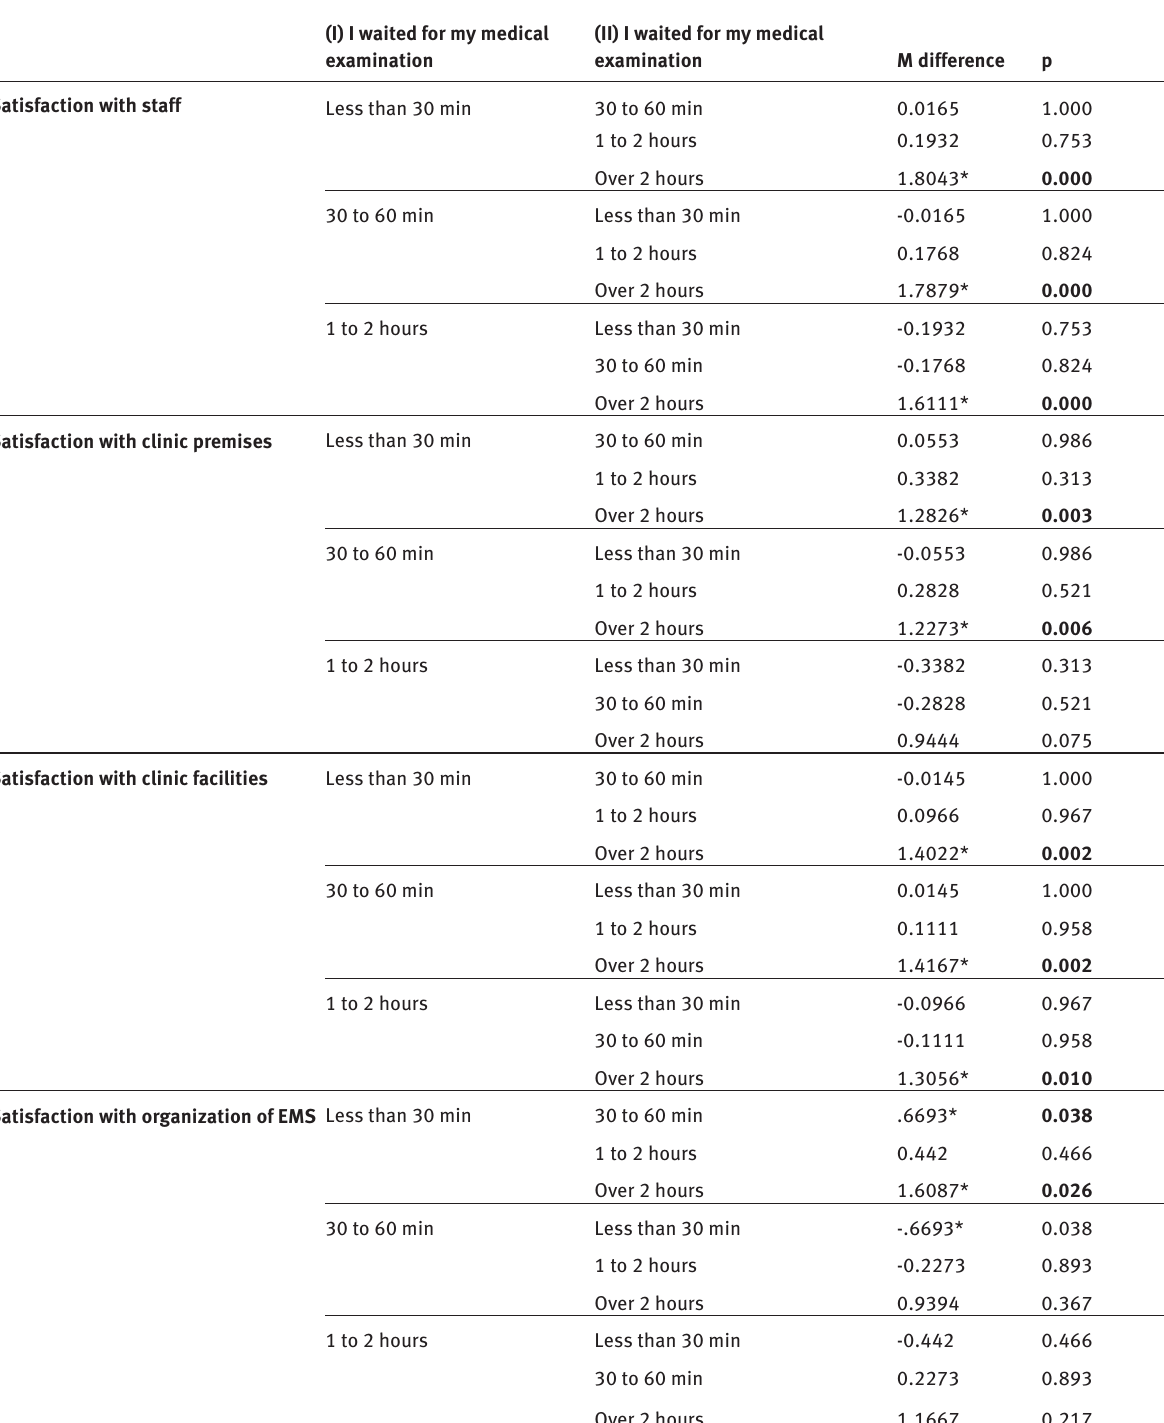
Table 4: Results of post hoc tests – impact of the effectiveness of the EMS organizational model on patient